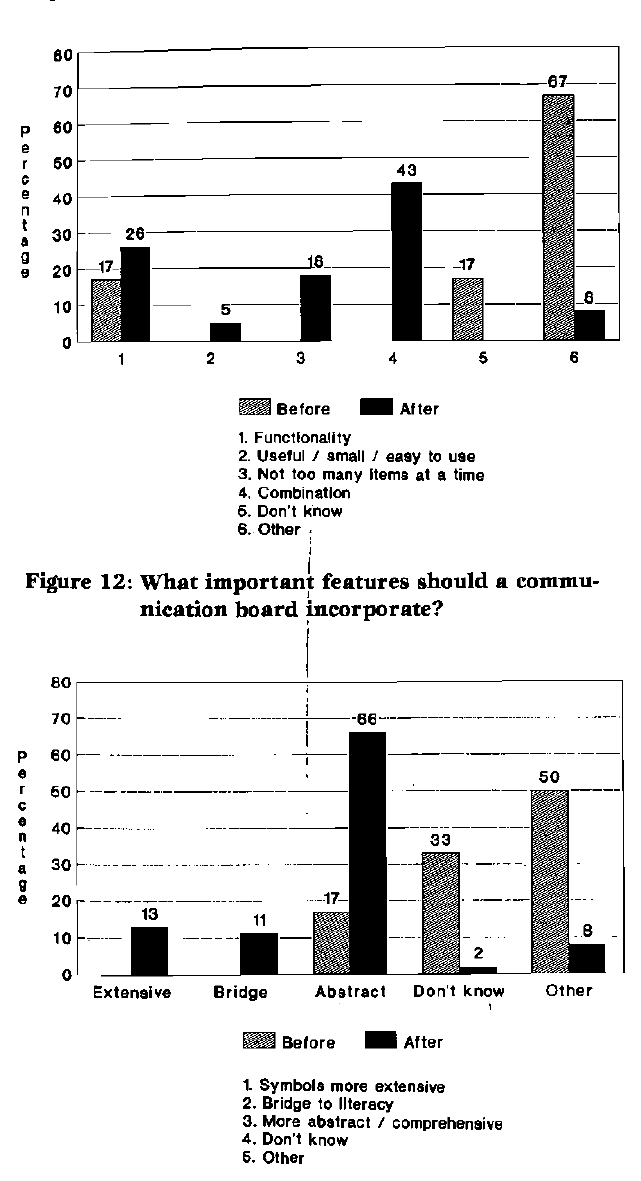
Figure 14: What are the biggest problems in using a symbol